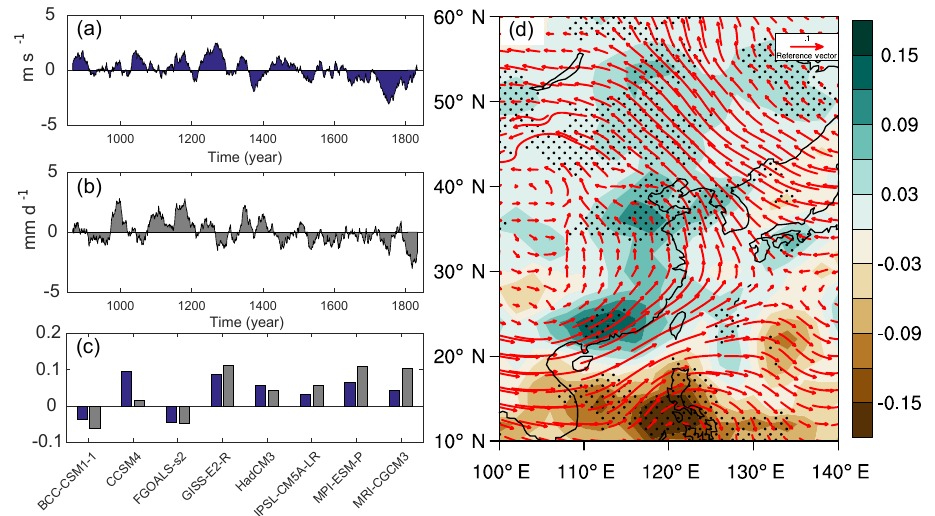
Figure 2. (a) Multi-model ensemble mean (MEM) of EASM strength anomalies relative to the long-term average (850–1850AD); panel (b) is the same as (a) but for regionally averaged summer precipitation anomalies over eastern China (20–45 ◦ N, 105–120 ◦ E); (c) difference in the EASM strength (blue) and regionally averaged summer precipitation over eastern China (gray) between the MCA and LIA; (d) MEM of spatial changes in winds (vectors, in ms − 1 ) and summer precipitation (shading, in mmd − 1 ) between MCA and LIA. Dotted areas show that at least six of eight models have the same sign as for MEM.